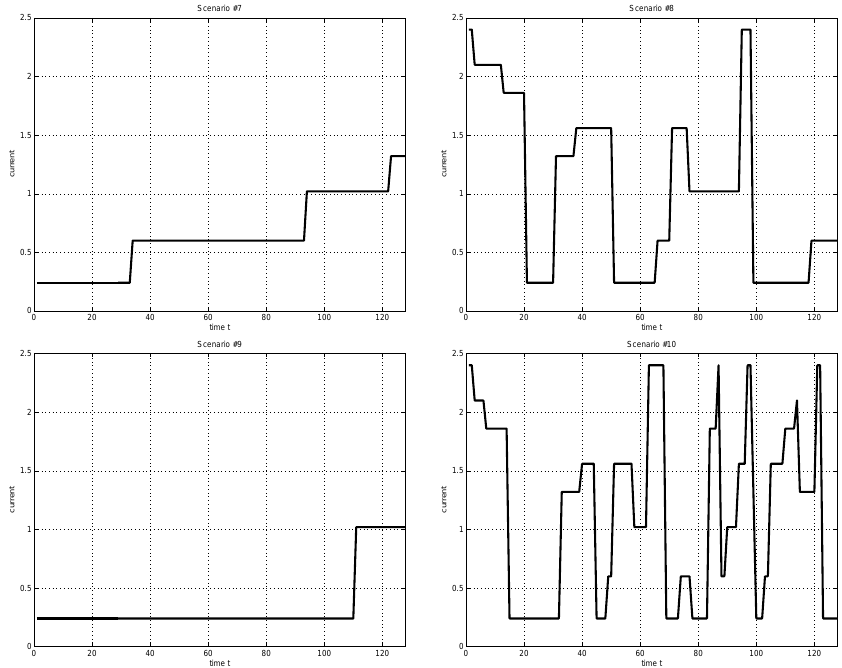
Figure 2. Considered workload scenarios, which are essentially based on the iPhone battery current measurements of